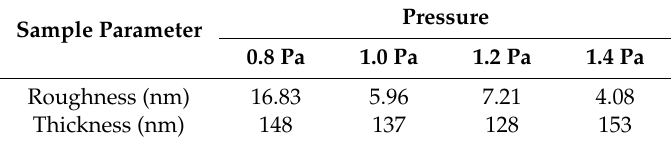
Table 2. Roughness and thickness of the MoS 2 films deposited at different pressures.